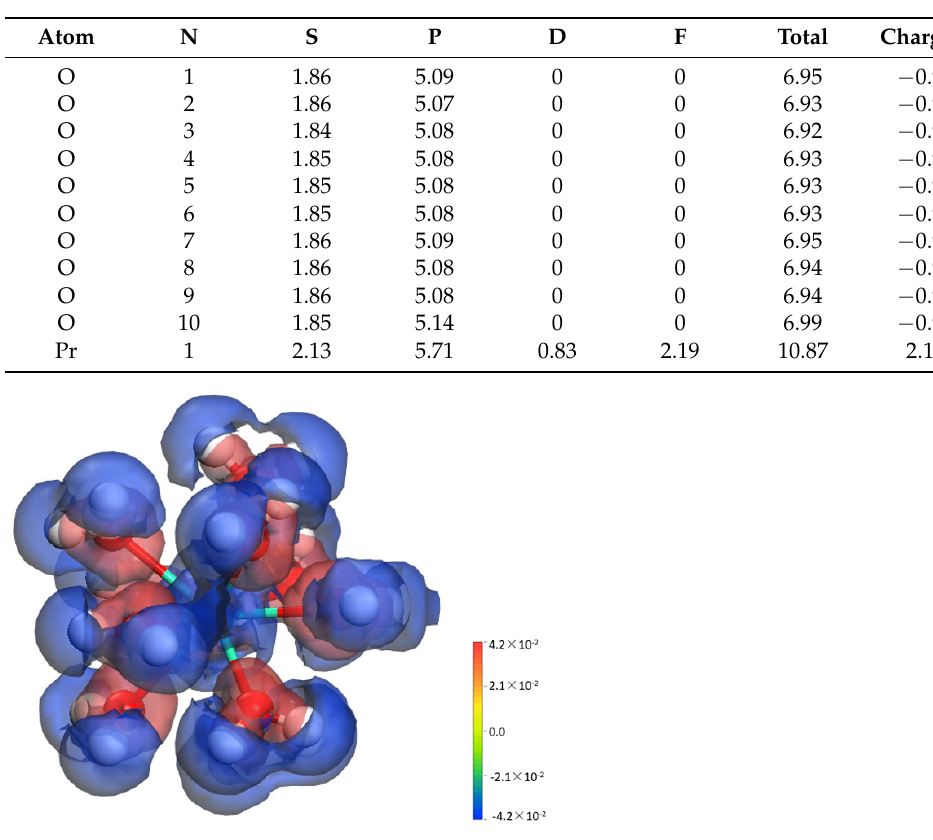
Atom Table 2. The Mulliken charge population of Pr and O in [Pr(H 2 O) 10 ] 3+ .